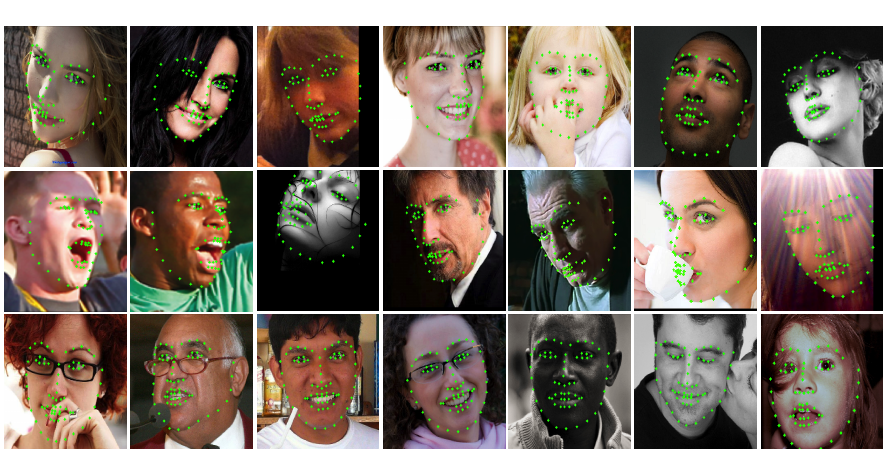
Figure 6. The CED curves for three subsets of 300 W.